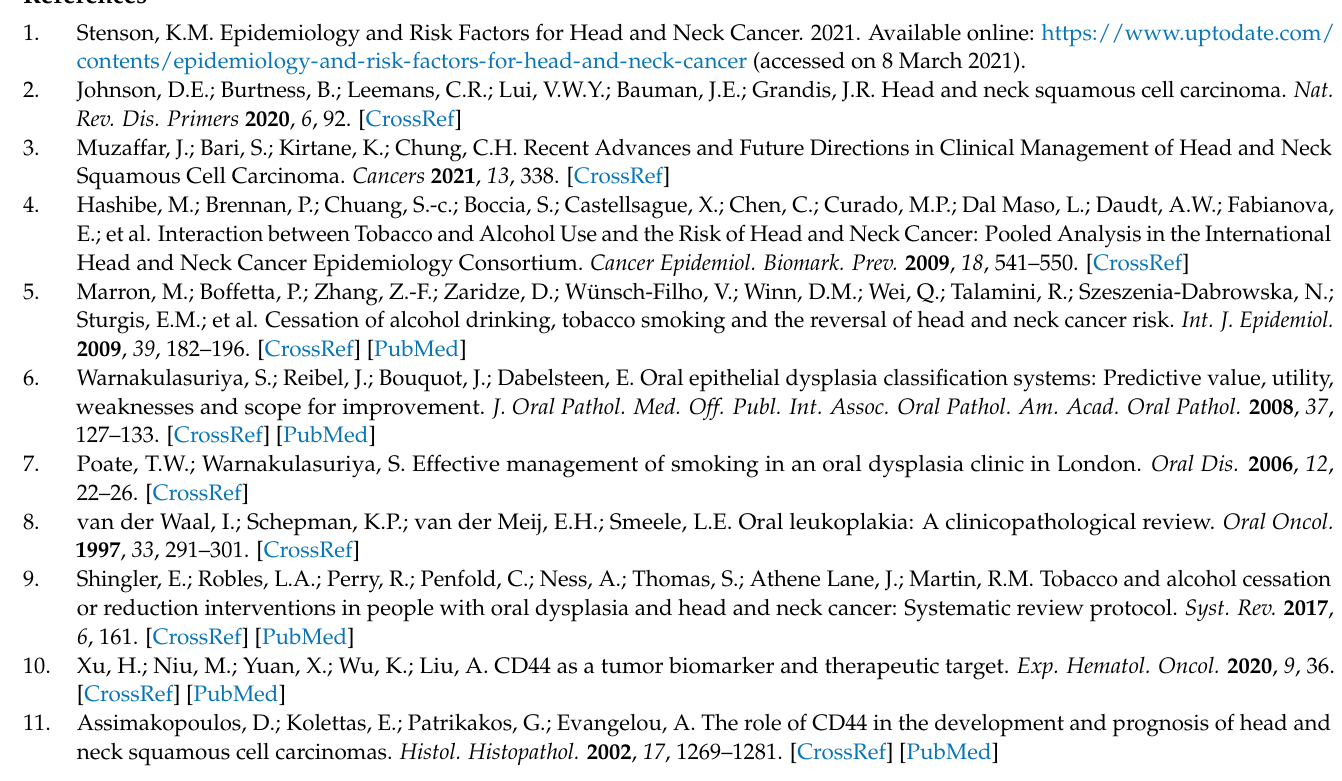
Table S3: Changes in Total Protein levels at 12 months following a smoking cessation